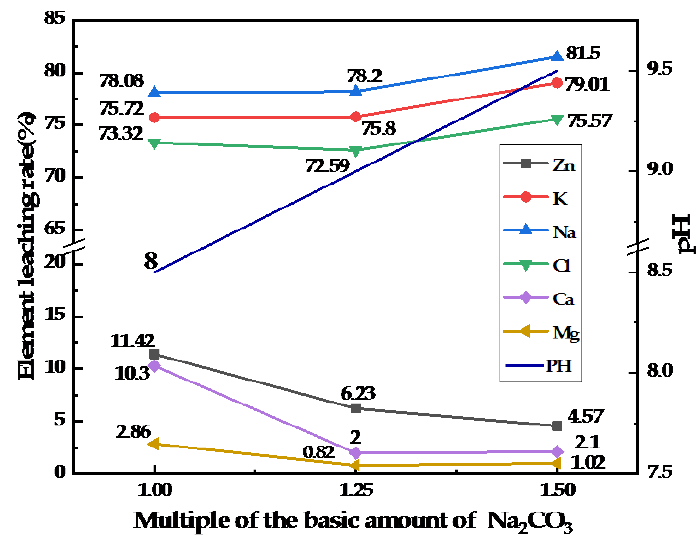
Figure 7. Leaching ratios of various elements with di ff erent Na 2 CO 3 additions at liquid–solid ratio of 6:1.